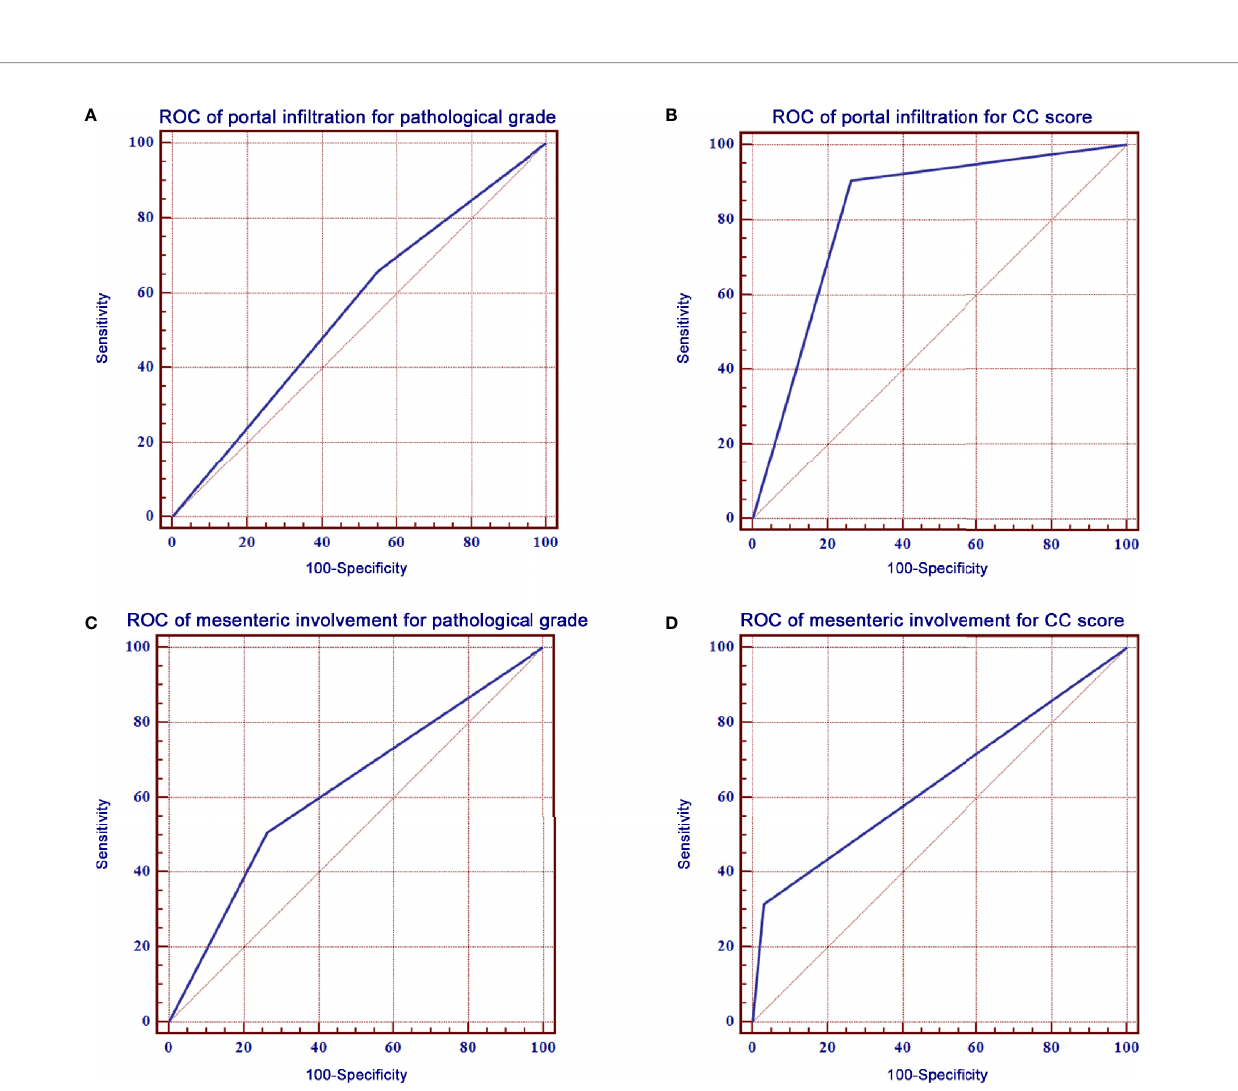
FIGURE 3 | ROC curves of portal in fi ltration, mesenteric involvement for pathological grade, and CC score. (A) ROC curve of portal in fi ltration showed a sensitivity of 66.0% and a speci fi city of 45.0% for pathological grade. (B) ROC curve of portal in fi ltration had a sensitivity of 90.4% and a speci fi city of 73.7% for the CC score. (C) ROC curve of mesenteric involvement showed a sensitivity of 66.0% and a speci fi city of 45.0% for pathological grade. (D) ROC curve of mesenteric involvement had a sensitivity of 90.4% and a speci fi city of 73.7% for CC